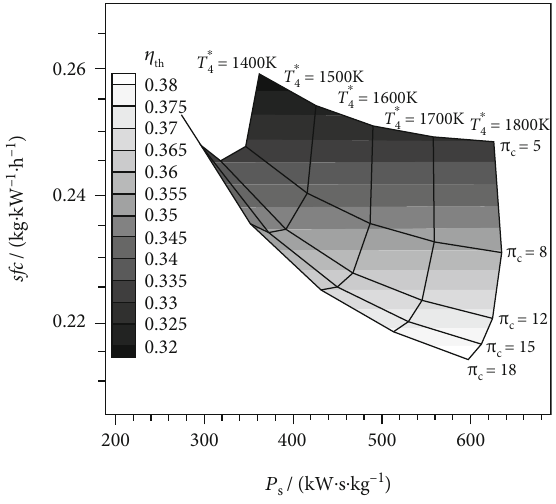
Figure 3: Variations in performance metrics with cycle parameters under standard sea-level condition.